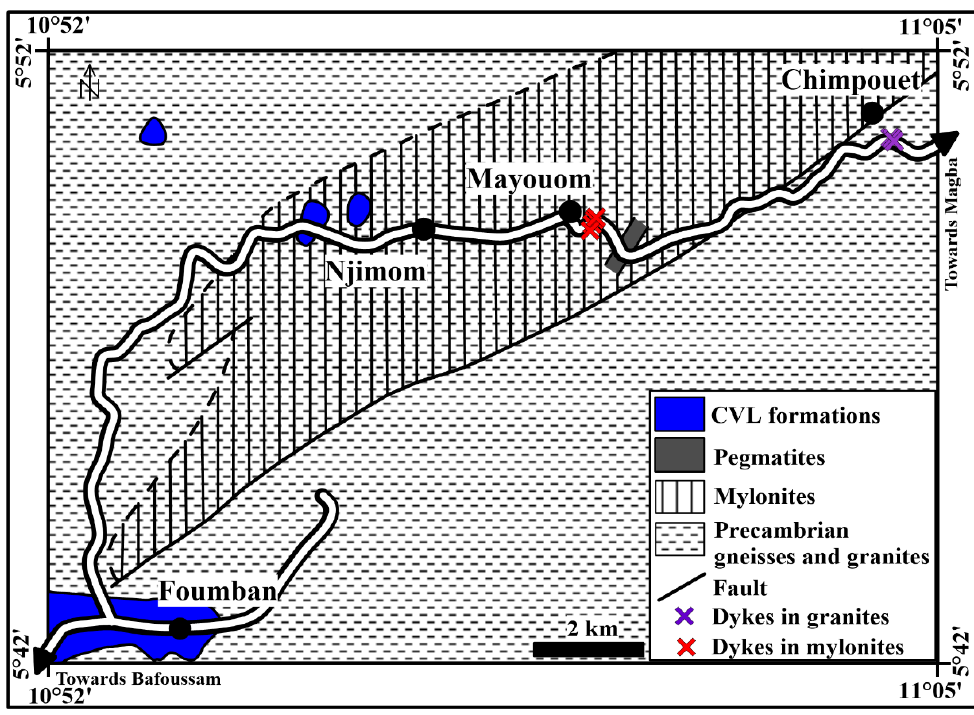
Figure 2. Geology sketch map of the Njimom area with location of the studied samples.